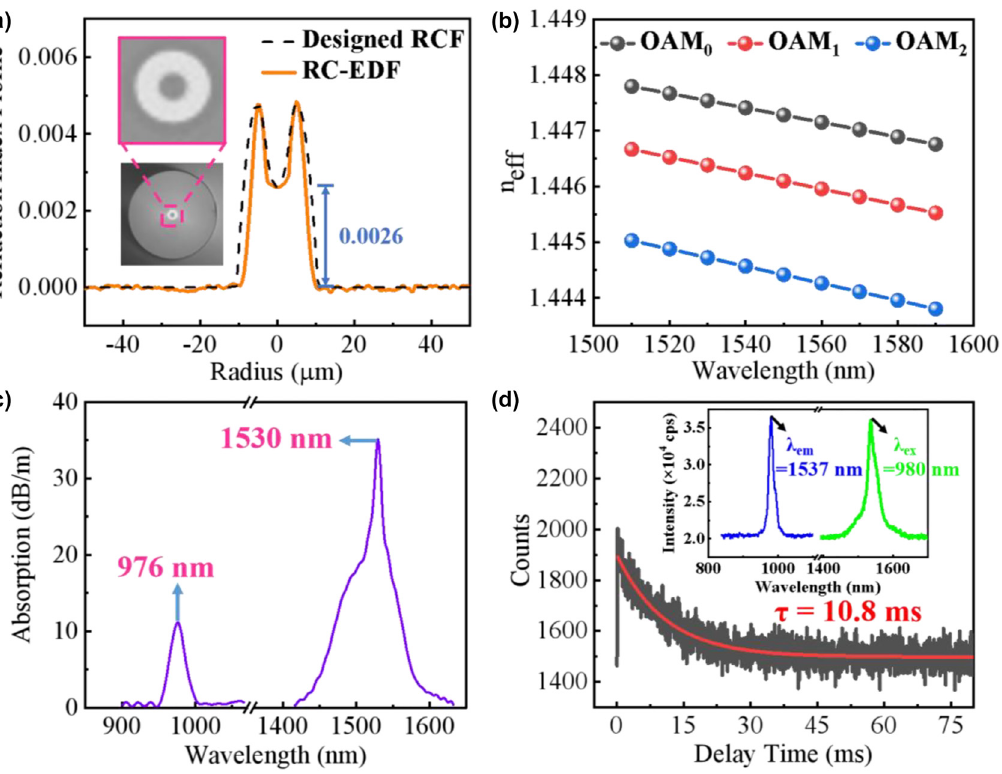
Figure 2: Parameters and properties of the fabricated RC-EDF. (a) RI profile (inset: cross section); (b) calculated n the wavelength; (c) Absorption spectrum of OAM